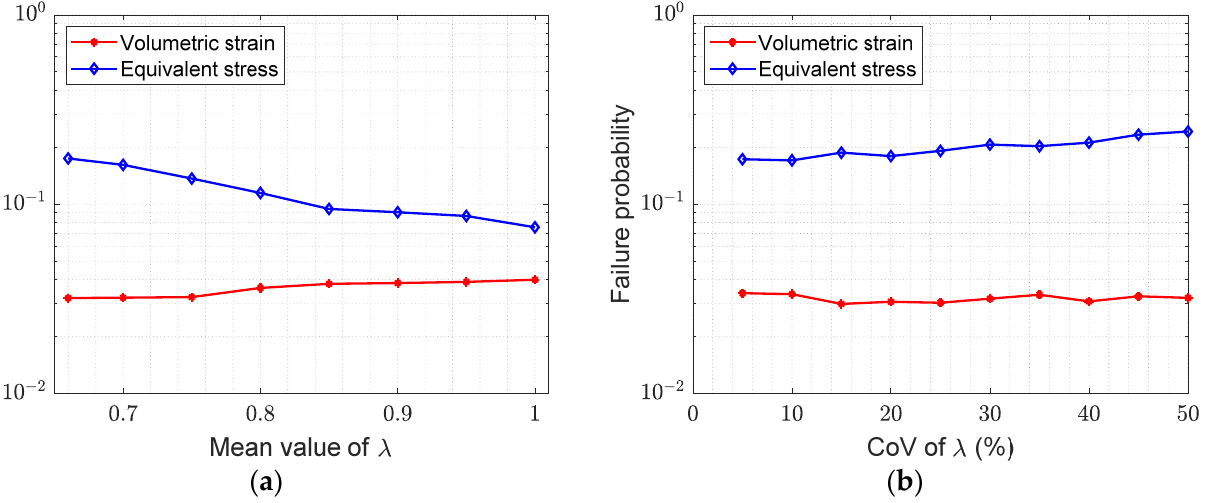
Figure 8. Comparison of failure probability of the tunnel supports in three studied cases of anisotropic and isotropic initial stresses considering different values of liners’ thickness: ( a ) volumetric strain of the flexible liner at the crown; ( b ) equivalent stress of the concrete liner at the springline.